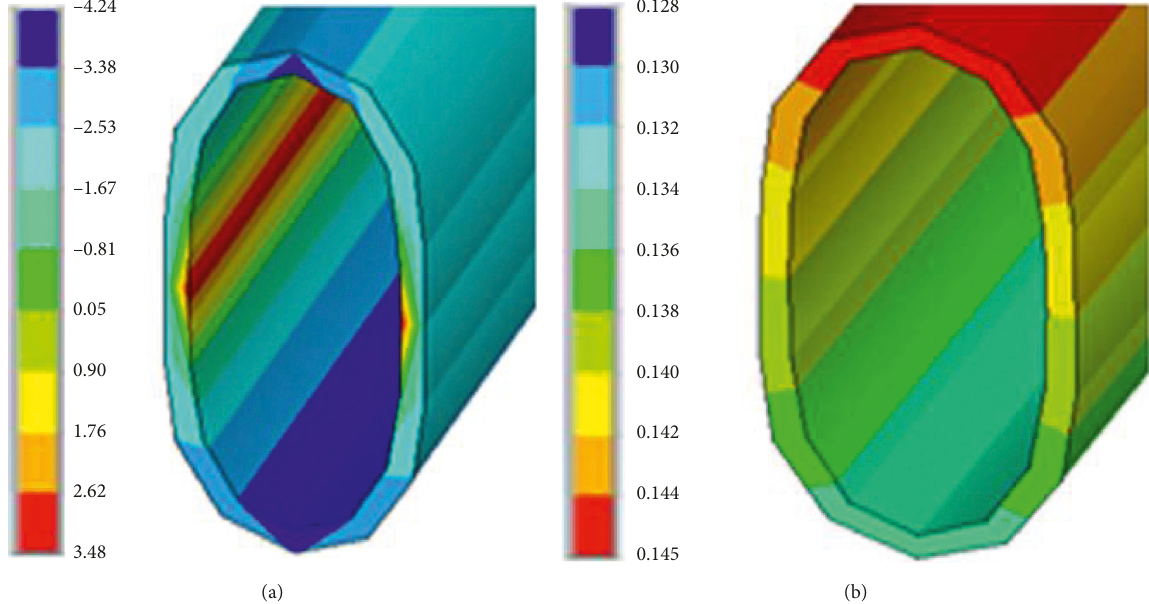
Figure 17: Thermal responses of the pipe with fluid circulation: (a) maximum principle stress distribution (MPa); (b) vertical displacement (mm).